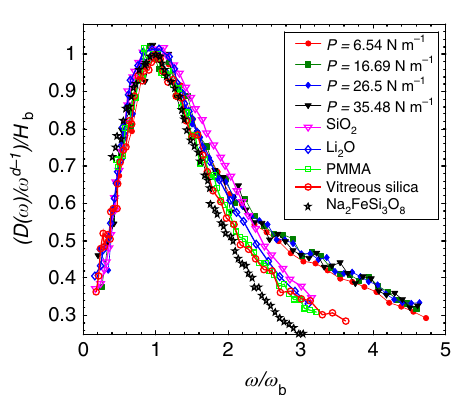
Fig. 4 Shape of rescaled BPs. Comparison of the re-scaled BPs (( D ( ω )/ ω d − 1 )/ H b vs. ω / ω b ) of our results and those found by Buchenau and colleagues 27 for vitreous silica ( red open circles ) and PMMA ( green open squares ), those found by Sokolov and colleagues 1 in molecular glasses Li 2 O ( blue diamonds ) and SiO 2 ( magenta inverted triangles ), and those found by Monaco et al. 37 in Na 2 FeSi 3 O 8 glasses ( black stars ). Here H b is the height of BP, ω b is the peak frequency, and d is the dimension with d = 2 in 2D and d = 3 in 3D. The fi lled symbols represent the data from the current experiment, and different symbols indicate different pressures corresponding to the curves in Fig.